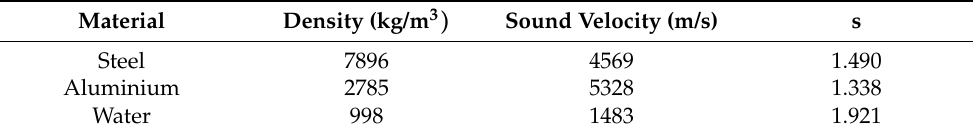
Table 1. Steel, aluminium and water shock equation of state parameters from [19] used to plot shock polar in Figure